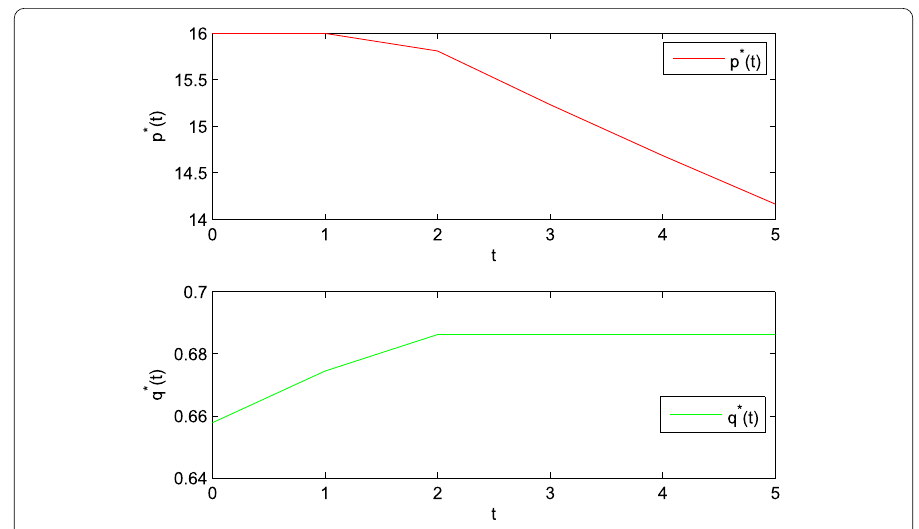
Figure 8 The effect of t on optimal premium strategy and reinsurance strategy